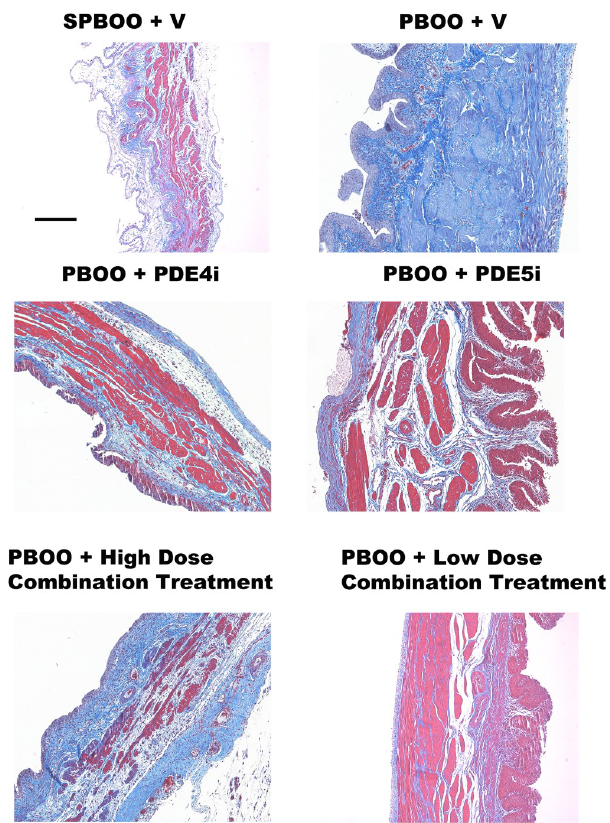
Fig 5. Examples of Masson’s trichrome-stained transverse sections of bladder from animals in all experimental groups: Sham partial bladder outlet obstruction (PBOO) and vehicle (SPBOO + V), PBOO and vehicle (PBOO + V), PBOO and PDE5i alone (PBOO + PDE5i), PBOO and PDE4i alone (PBOO + PDE4i), PBOO and high dose combination treatment (PBOO + high dose combination treatment) and PBOO and low dose combination treatment (PBOO + low dose combination treatment). Scale Bar is 100 μ m in length. Collagen signifying fibrosis is stained blue, muscle is stained